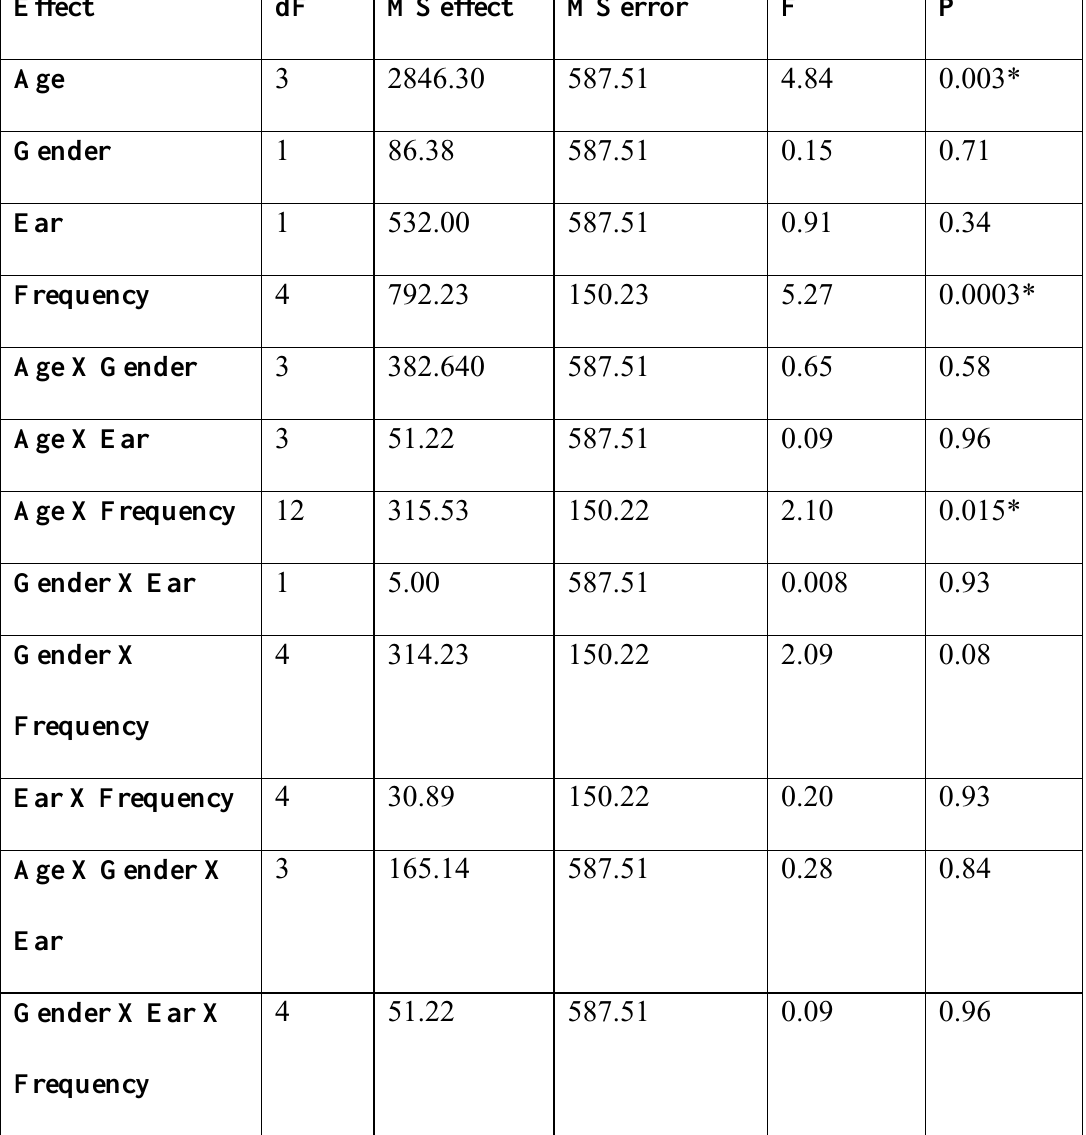
Table 2. MANOVA results showing effects of age, gender, ear, and audiometric frequency on